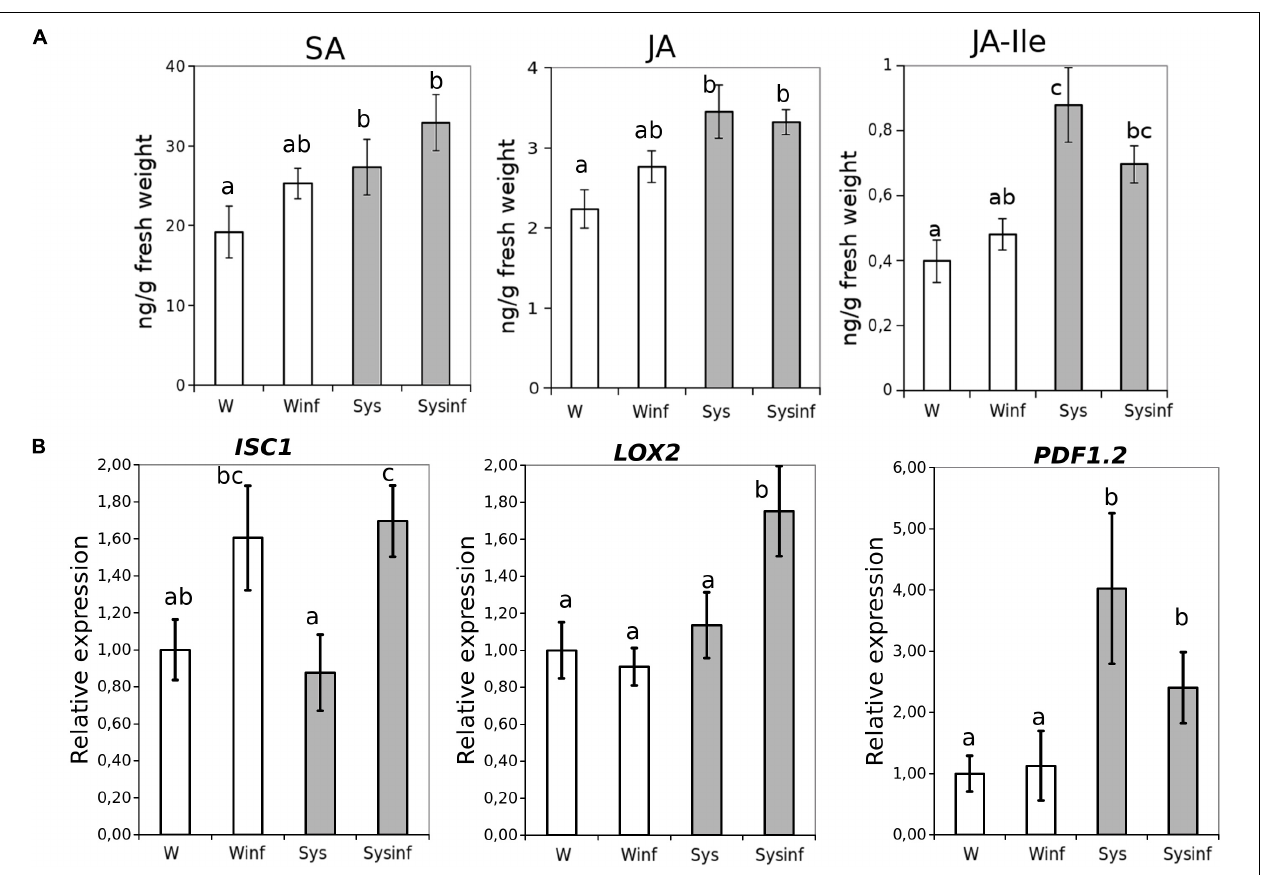
FIGURE 4 | Systemin treatment impact in hormonal profiles. (A) Salicylic acid (SA), Jasmonic acid (JA) and JA-isoleucine (JA-ile) hormone quantitative levels (ng/g fresh weight) measured in Arabidopsis seedlings 48 h after P. cucumerina infection in control (W) control infected (W inf) 24 h Systemin-pretreated (Sys) and 24 h Systemin-pretreated infected (Sys inf) plants by targeted HPLC-MS analysis. (B) Quantitative reverse transcription-polymerase chain reaction analysis of ICS1 , LOX2, and PDF1.2 in seedlings 48 h after P. cucumerina infection in Water plants “W,” water infected plants “W inf,” 0.1 nM Systemin treated plants “Sys” and Sys infected plants “Sys inf.” Bars represent mean ± standard error (SD), n = 6. Different letters represent statistically significant differences. (ANOVA, Fisher’s Least Significant Difference (LSD) test; P < 0.05, n =